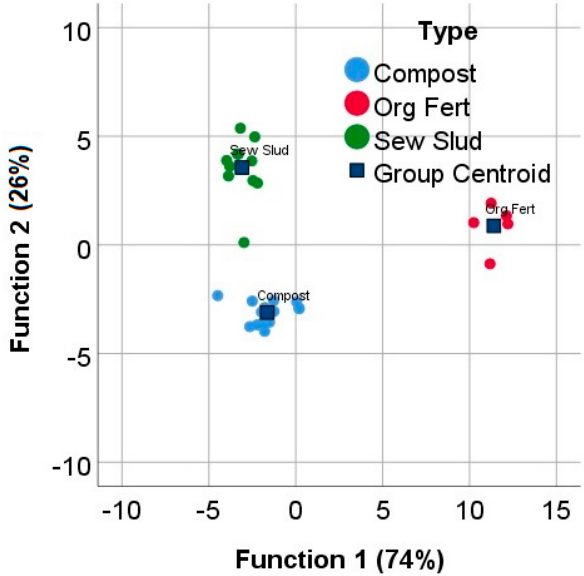
Figure 1. Canonical discriminant functions for the three types of organic amendments using pXRF readings as input variables (missing values corresponding to readings below LOD are replaced with a 0).